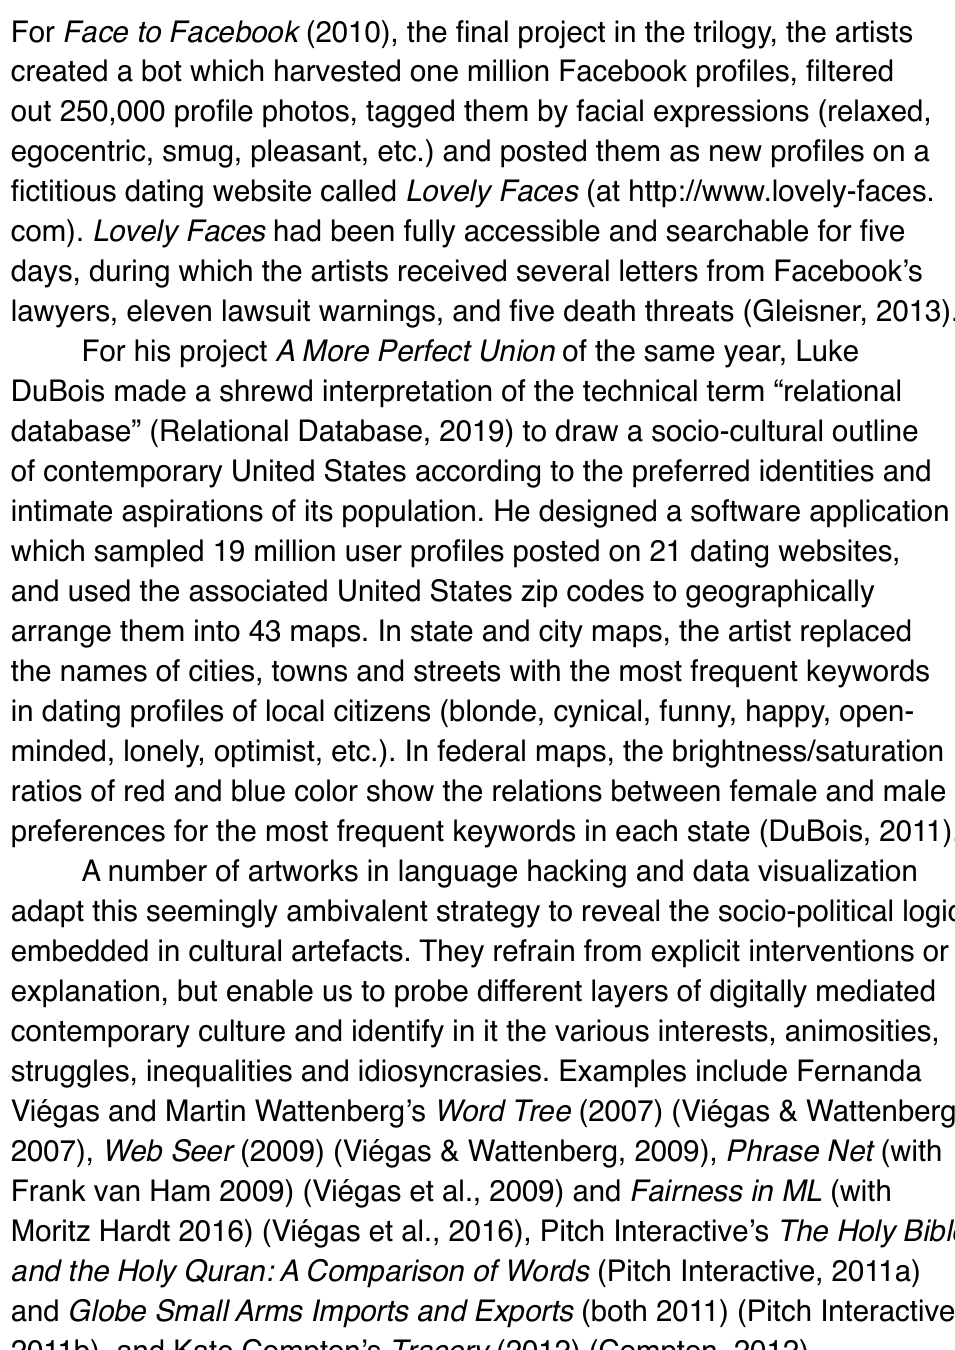
Figure 7: Paolo Cirio and Alessandro Ludovico, Face to Facebook (2010). Artists as Catalysts exhibition in Alhóndiga, Bilbao, Spain. © Image courtesy of Paolo